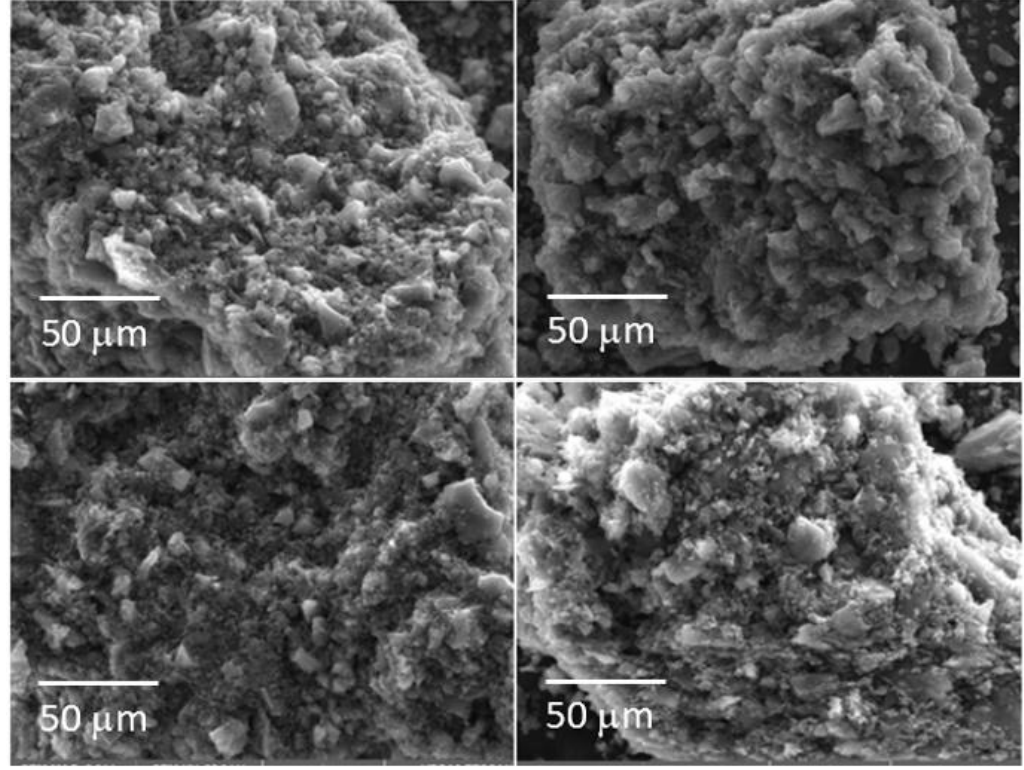
Figure 5. Morphology of the hard carbons after activation with KOH recorded at low magnification. Upper left : apricot kernel; ( upper right ): cherry stone. ( Lower left ): olive stone; ( lower right ): walnut shell.